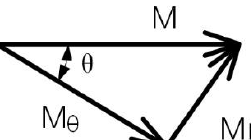
Figure 6. Geometric relationship of magnetization components.